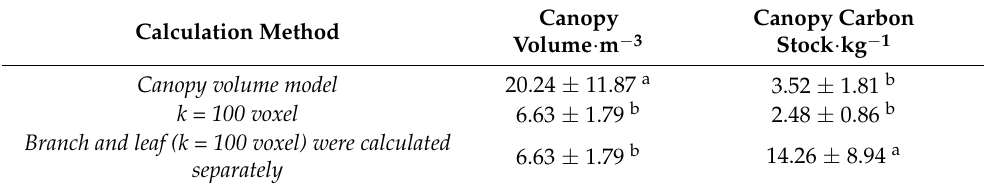
Table 2. Comparison of volumes and carbon stocks for canopies as calculated by different methods.